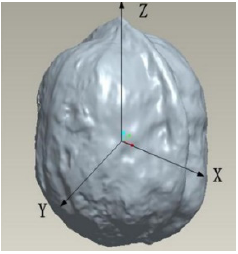
Figure 10. Walnut 3D scanned model.